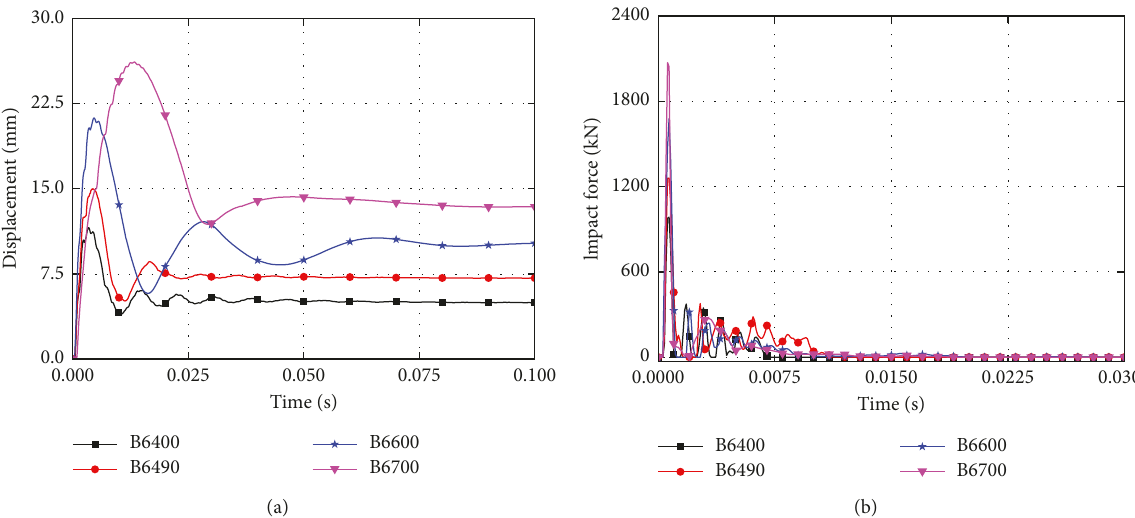
Figure 15: Comparison of impact response (constant quality and variable speed). (a) Comparison of midspan displacement. (b) Comparison of impact force.